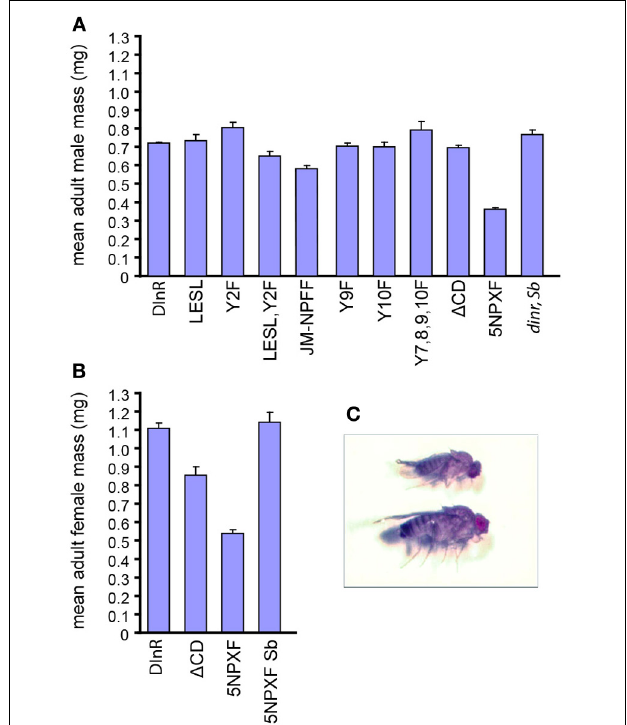
FIGURE 4 | Chico interaction sites are required for whole animal growth. (A,B) Mean mass (mg) of male (A) and female (B) adult dinr ex15/273 flies expressing different UAS-DInR variants. Error bars represent standard error. Sample numbers for each rescue protein tested in males were: DInR control, 85; DInR-LESL, 10; DInR-Y2F, 5; DInR-LESL,Y2F, 4; DInR-JM-NPFF, 33; DInR-Y9F, 10; DInR-Y10F, 5; DInR-Y7,8,9,10F, 2; DInR- (cid:2) CD, 27; DInR-5NPXF, 24; DInR control expressed in dinr mutant heterozygote siblings, 4. Sample numbers for each rescue protein tested in females were: DInR control, 32; DInR- (cid:2) CD, 8; DInR-5NPXF, 9; DInR-5NPXF expressed in dinr mutant heterozygote siblings, 3. (C) Photograph showing an example of a small dinr mutant adult fly expressing DInR-5NPXF (top) compared to heterozygous sibling control expressing DInR-5NPXF